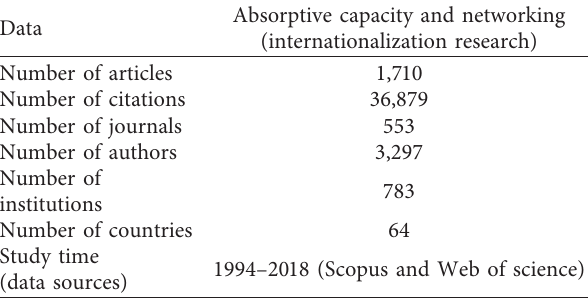
Table 1: Summary of data.